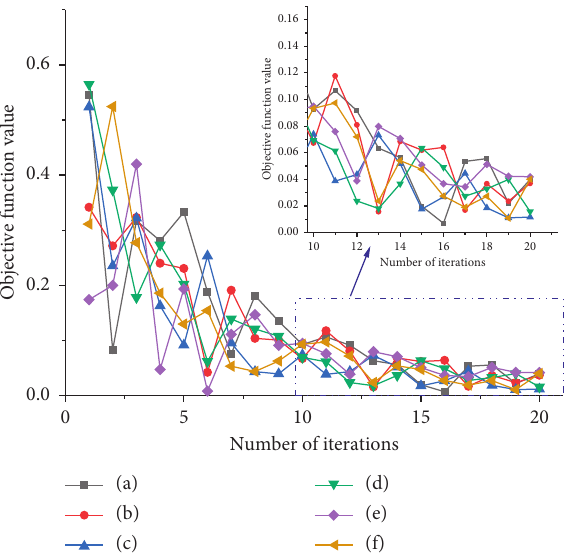
Figure 18: The convergence results of CSI with random